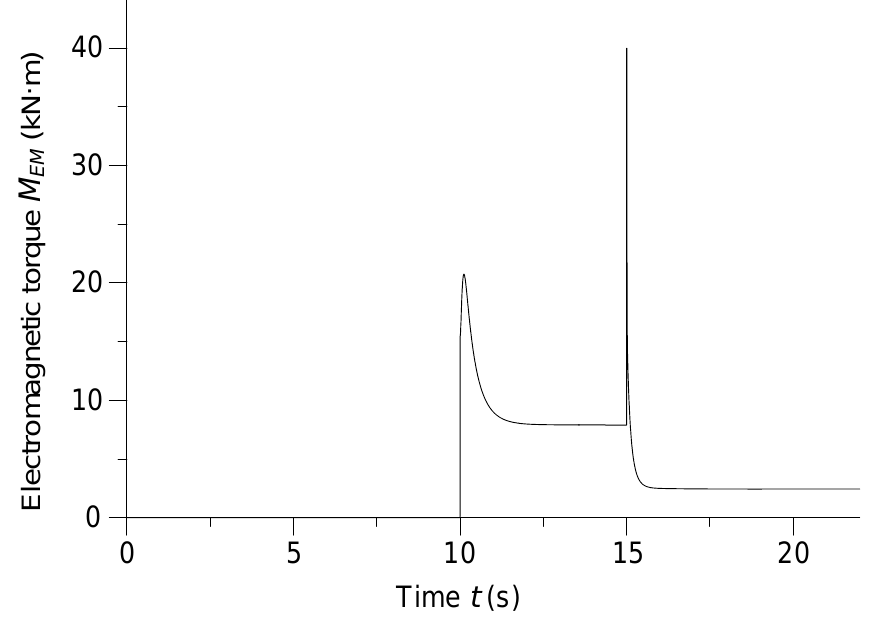
Figure 12. The instantaneous electromagnetic torque of the shaft generator. Figure 13 shows the angle of rotation of the long drive shaft as a function of the shaft length during a three-phase symmetrical short circuit of the shaft generator armature windings for 15.1 s.